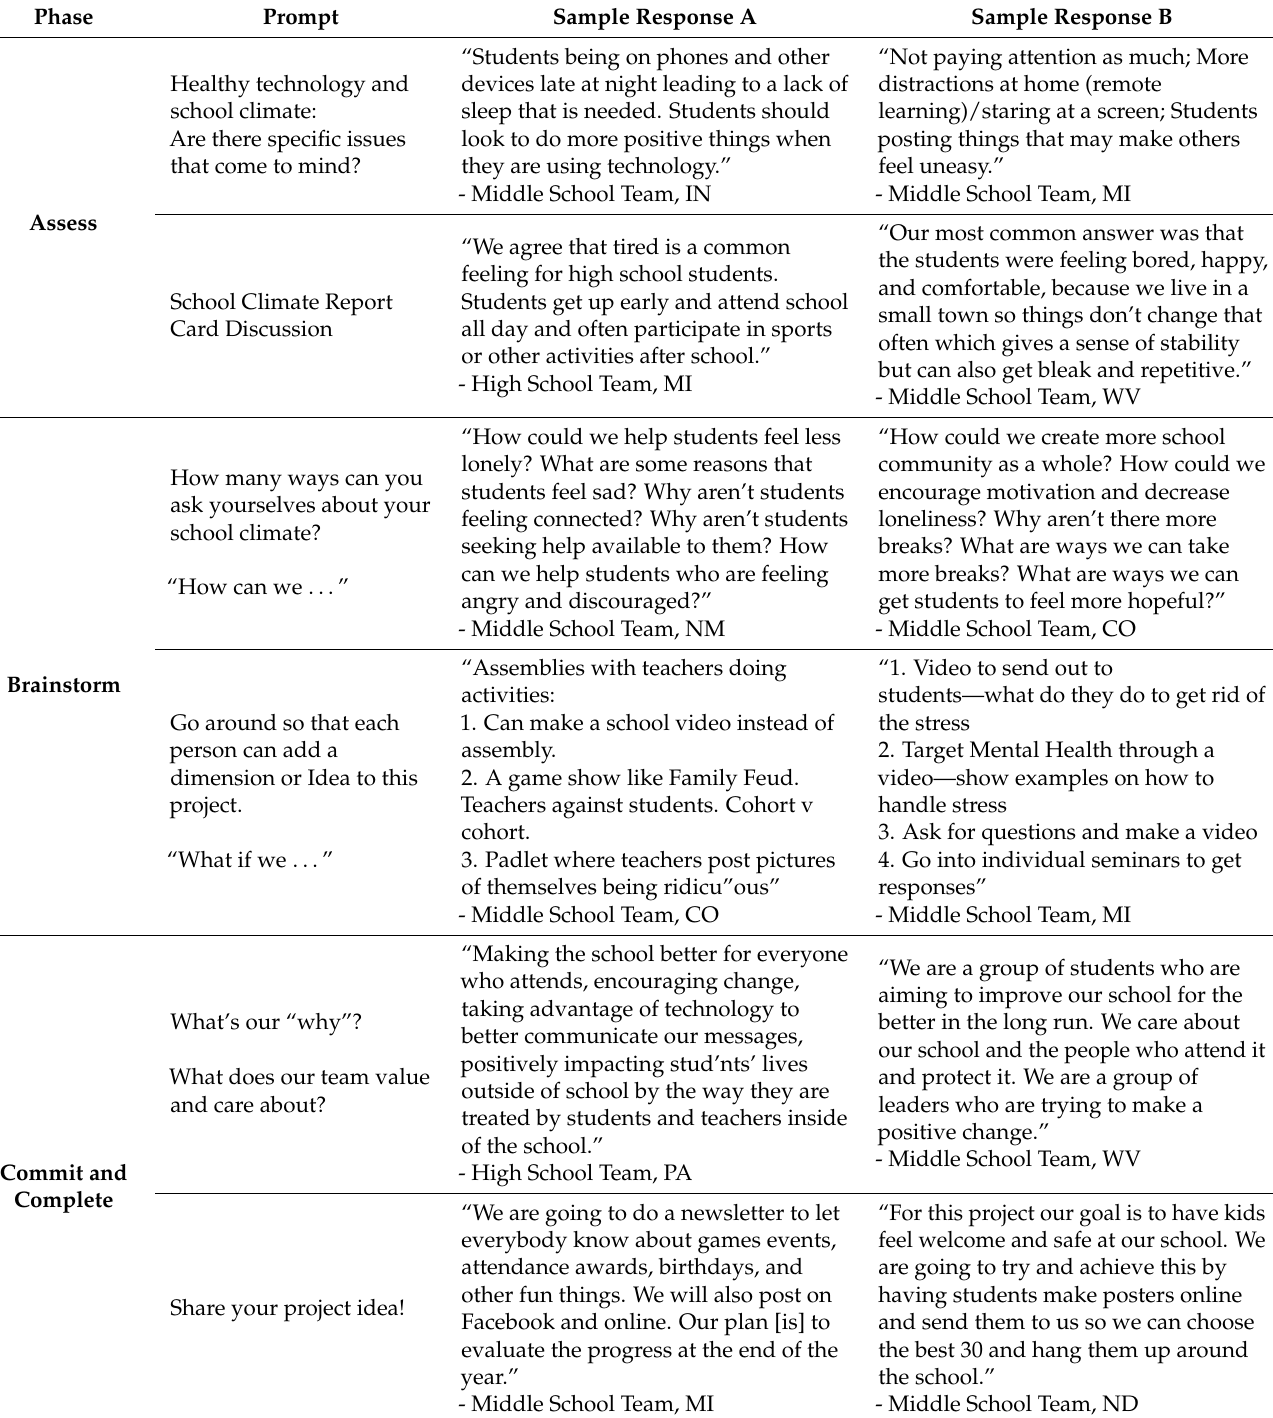
Table 1. Sample team responses to inspirED asynchronous training